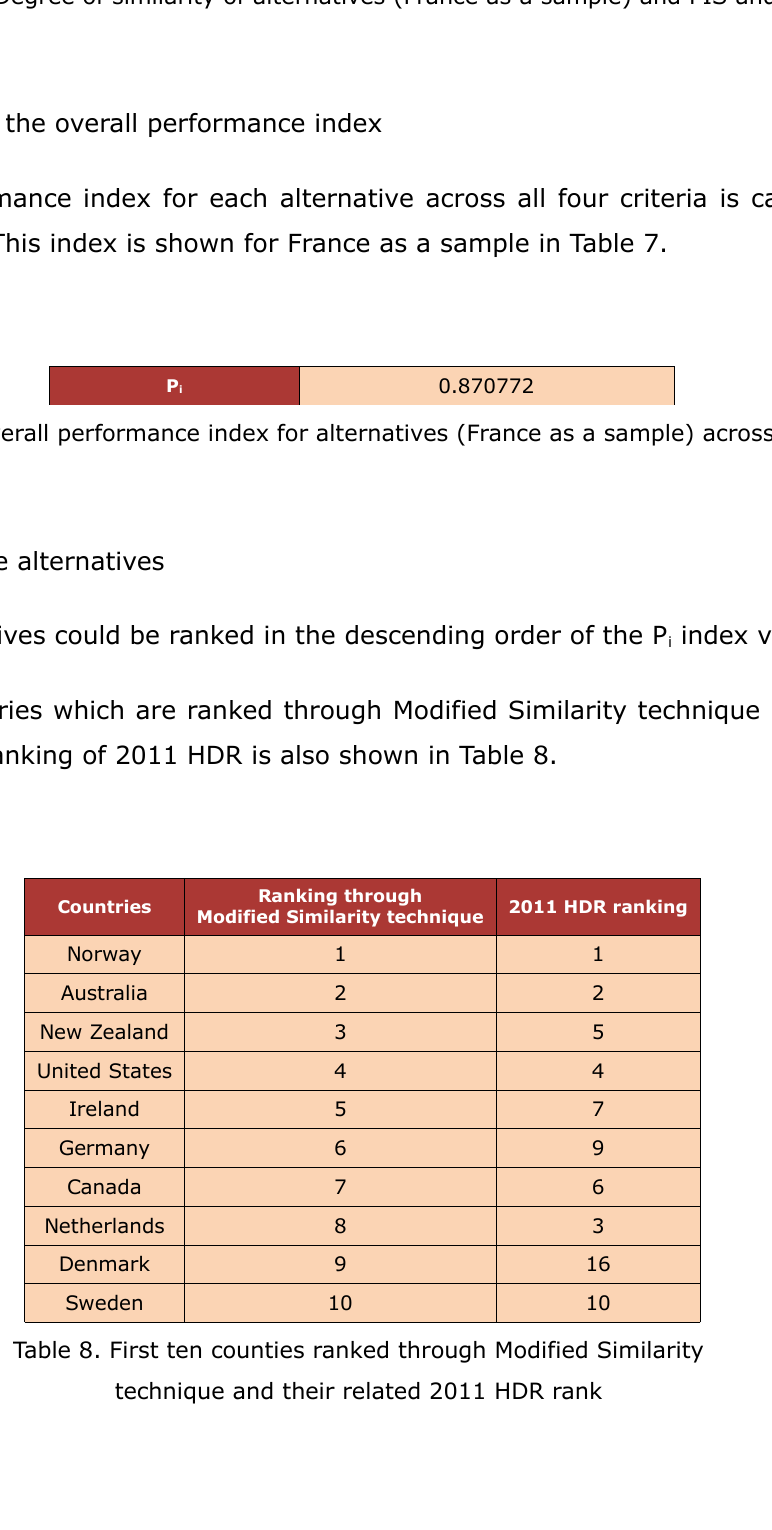
Table 7. The overall performance index for alternatives (France as a sample) across all criteria